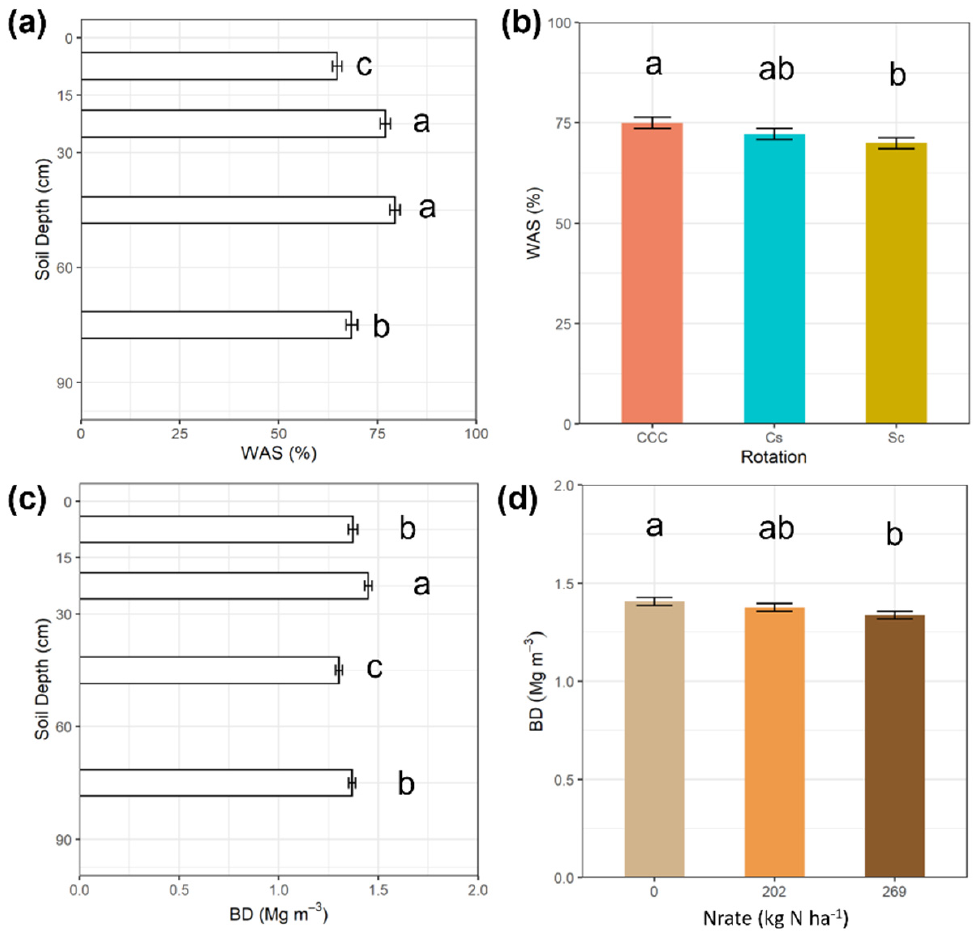
Figure 4. Mean water aggregate stability of the soil aggregates (WAS, %) determined for each ( a ) depth and ( b ) crop rotation. Mean soil bulk density (BD, Mg m − 3 ) determined for each ( c ) depth and ( d ) N fertilization rate. In both plots, bars show the mean values and the error bars represent the standard error of the treatment means. Crop rotations are continuous corn (CCC), and the corn- soybean rotation (CS) as corn Cs and soybean (Sc) phase, respectively. The N fertilization rates were 0, 202, and 269 (kg N ha − 1 ). Within each panel, means followed by the same lowercase letters are not statistically different ( α = 0.05). The average corn crop yield over the 36 years differed significantly ( p < 0.0001) between rotations, N rate, and their interaction (Table 2). Overall, the mean corn grain yield over the experimental period was significantly ( p < 0.0001) greater with N fertilization compared to N0, and following soybean in the corn-soybean rotation (CS) instead of after corn in the CCC (Figure 7). There were no significant yield increases between the top N levels, N202 and N269, over the study period. On average, corn yields increased 60% with N fertilization, and they increased the most when N was added into the unfertilized systems. Averaged across N rates, CS resulted in 31% higher average corn grain yield (11.07 Mg ha − 1 ) than under CCC (8.44 Mg ha − 1 ) ( p < 0.0001) management. Increasing the rate of N application resulted in greater corn grain yield for both CCC and CS systems (Figure 7), with values ranging from 4.90 (N0) to 10.34 (N269) Mg ha − 1 for CCC and 8.88 (N0) to 12.16 (N269) Mg ha − 1 for CS ( p < 0.0001). Compared to the unfertilized controls, the averaged corn grain yield in treatments was 45% higher in the CCC system and 37% higher in the CS system, indicating a greater response to N fertilizer in the CCC system. Likewise, within N0, rotated corn yielded 45% more than CCC. Yet, once N was supplied, the additional gain from soybean decreased to 17%. Because the experiment was